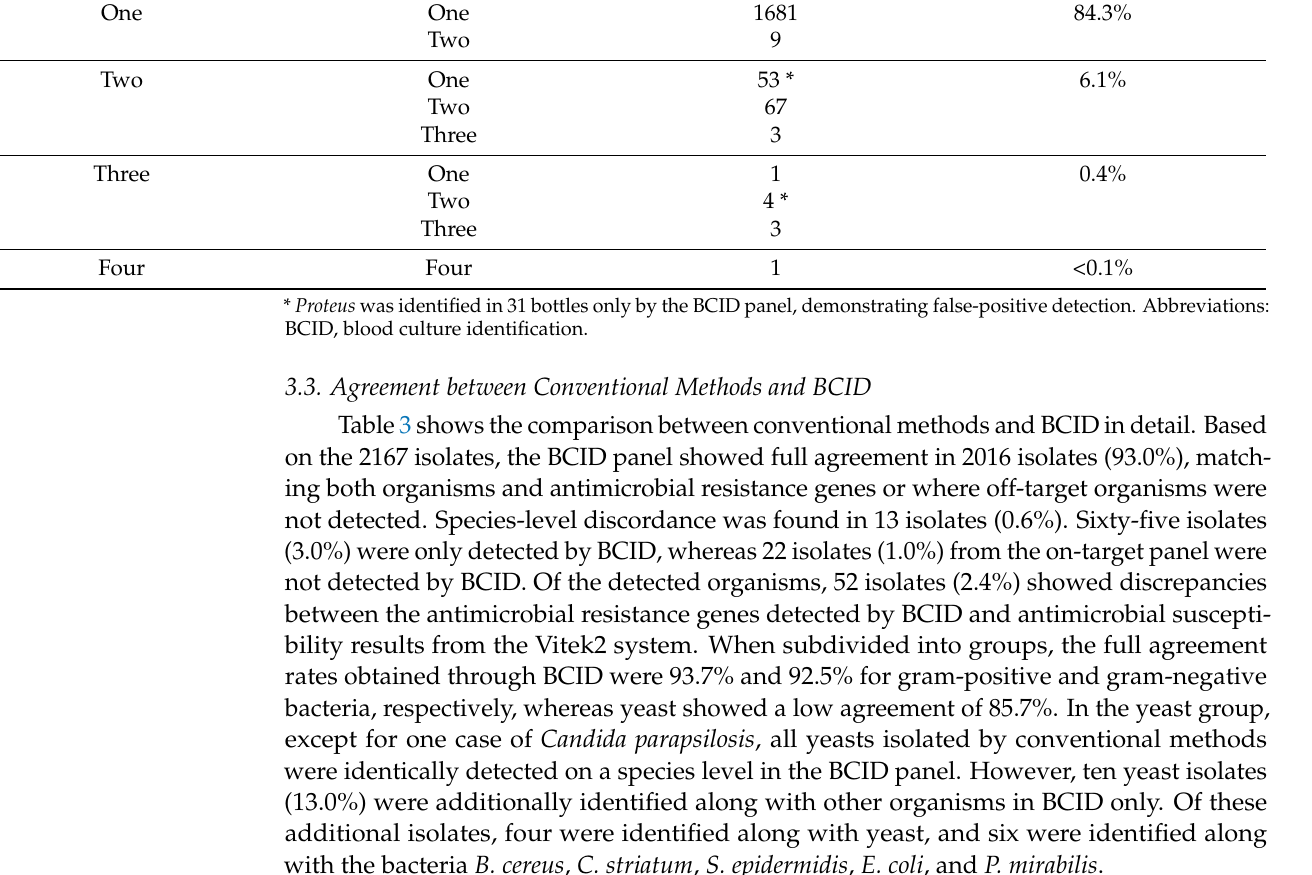
Table 2. Number of microorganisms isolated from positive blood culture bottles. Number of Microorganisms Detected No. of Bottles % of Total Bottles In